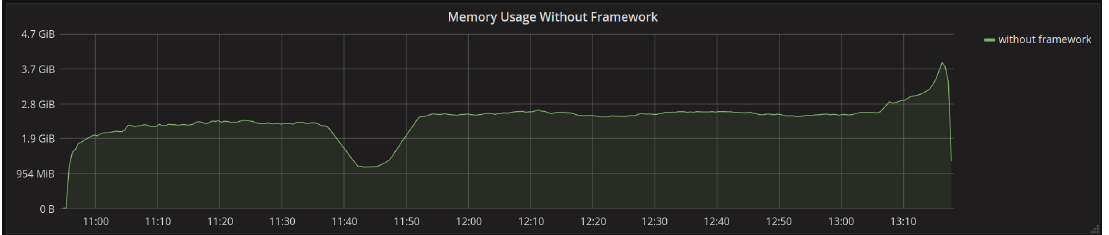
Figure 7. Memory usage without the framework run as single executable.